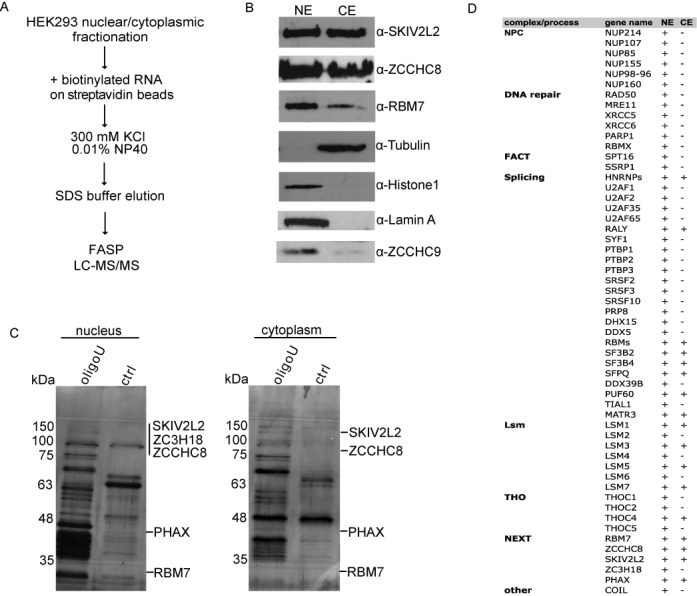
List of proteins bound to U30 RNA in HEK293 cells. (A) A schematic overview of the protocol. FASP stands for filter-aided sample preparation. (B) Western blot analysis of the cell fractionation. Tubulin was used as a cytoplasmic marker, and histone H1, lamin A and ZCCHC9 represented nuclear markers. (C) Protein profiles in control and U30 RNA-bound nuclear and cytoplasmic extracts. Equal amounts of eluates from control RNA (Ctrl) and U30 RNA bait fractions were separated on 12% SDS-PAGE gel and silver stained. (D) List of selected factors accumulated exclusively on the U30 RNA in human and mouse cells (24) in at least one replicate. The factors are grouped based on protein complexes they form. The last two columns display the presence (+) or absence (−) of particular protein in nuclear (NE) or cytoplasmic (CE) fraction, respectively. For full list of proteins see Supplementary Tables S1 and S2. NPC—nuclear pore complex, FACT—facilitates chromatin transcription/transactions complex, Lsm—SM-like genes forming U6 snRNP complex, THO—ribonucleoprotein nuclear export complex, NEXT—nuclear exosome targeting complex.